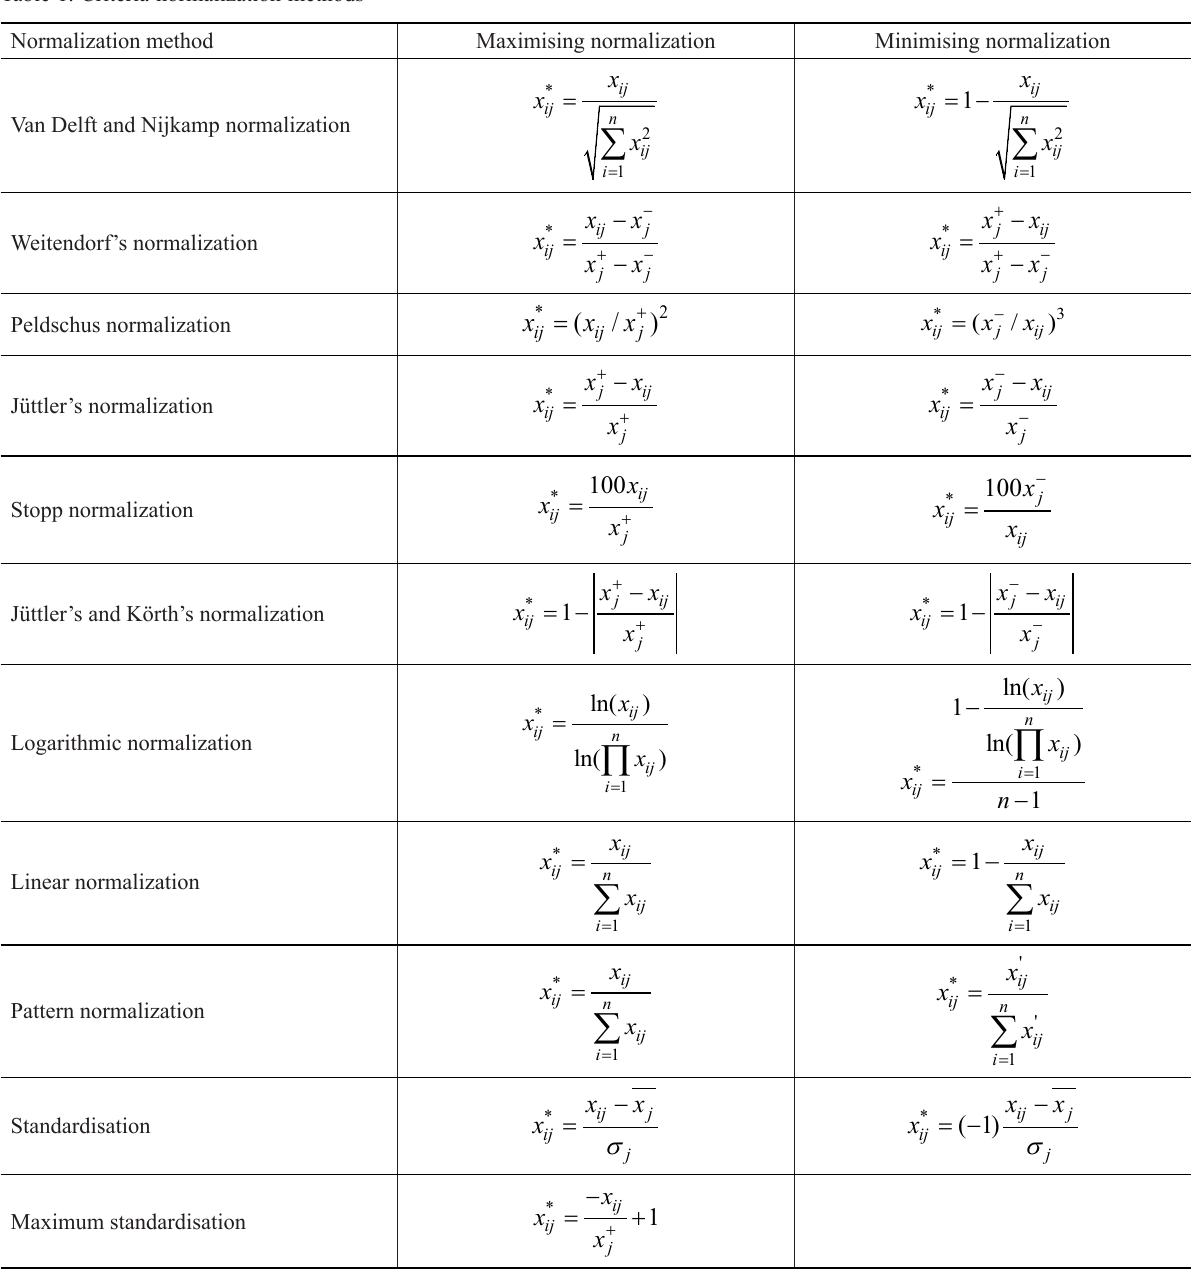
Table 1. Criteria normalization